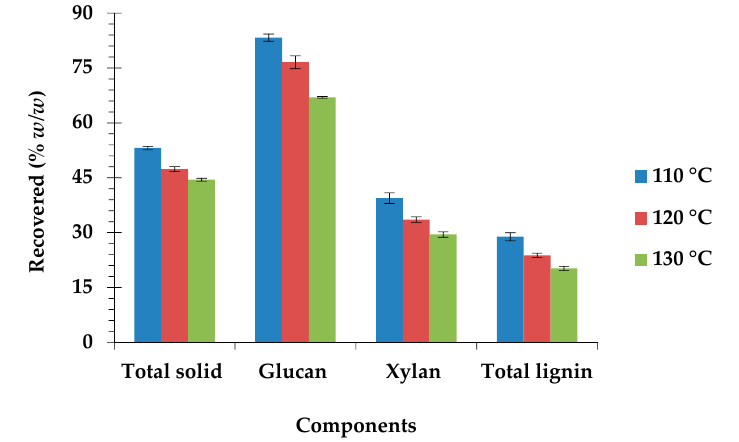
Figure 2. Effect of autoclave temperature on the composition of C . barbata .